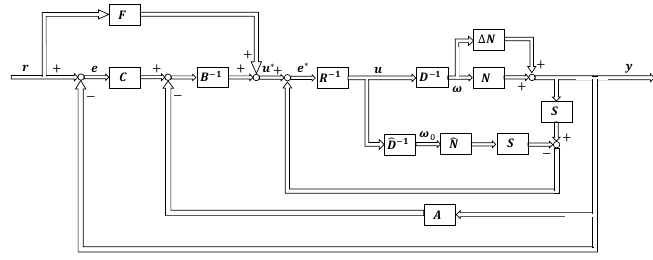
Figure 5. Block diagram of the proposed control system.